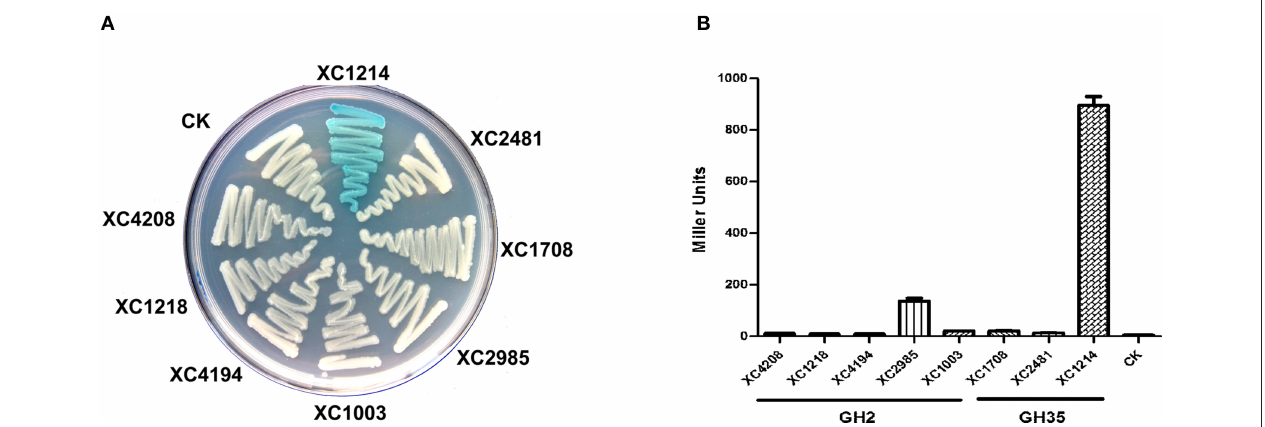
FIGURE 2 | β -galactosidase activities of Xcc GH2 and GH35 proteins expressed in E. coli . (A) Morphology of GH2- and GH35-expressing E. coli cultured on X-gal containing media. (B) The β -galactosidase activities of GH2- and GH35-expressing E. coli . CK: E. coli containing the empty vector. Triplicate experiments were performed , and the means ± standard deviations ( SD s) were calculated.